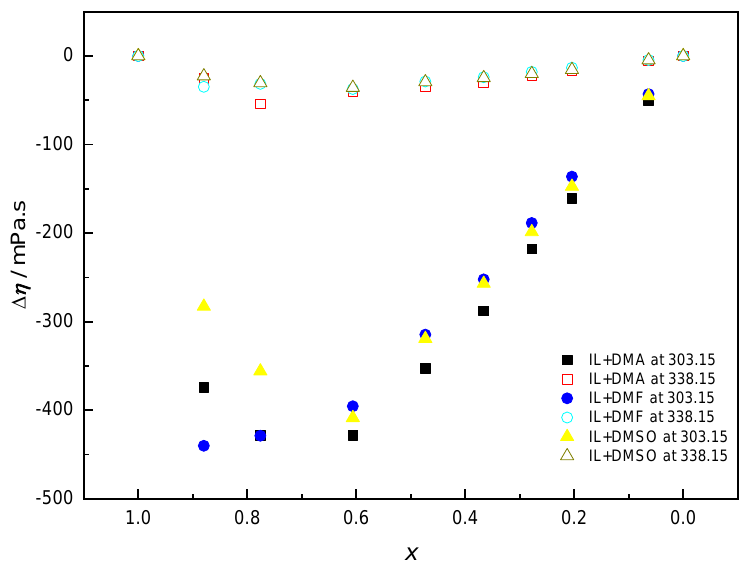
Figure 4. The viscosity deviations of binary mixtures for [C 6 mim] [OAc] with solvents as a function of ionic liquid mole fraction.